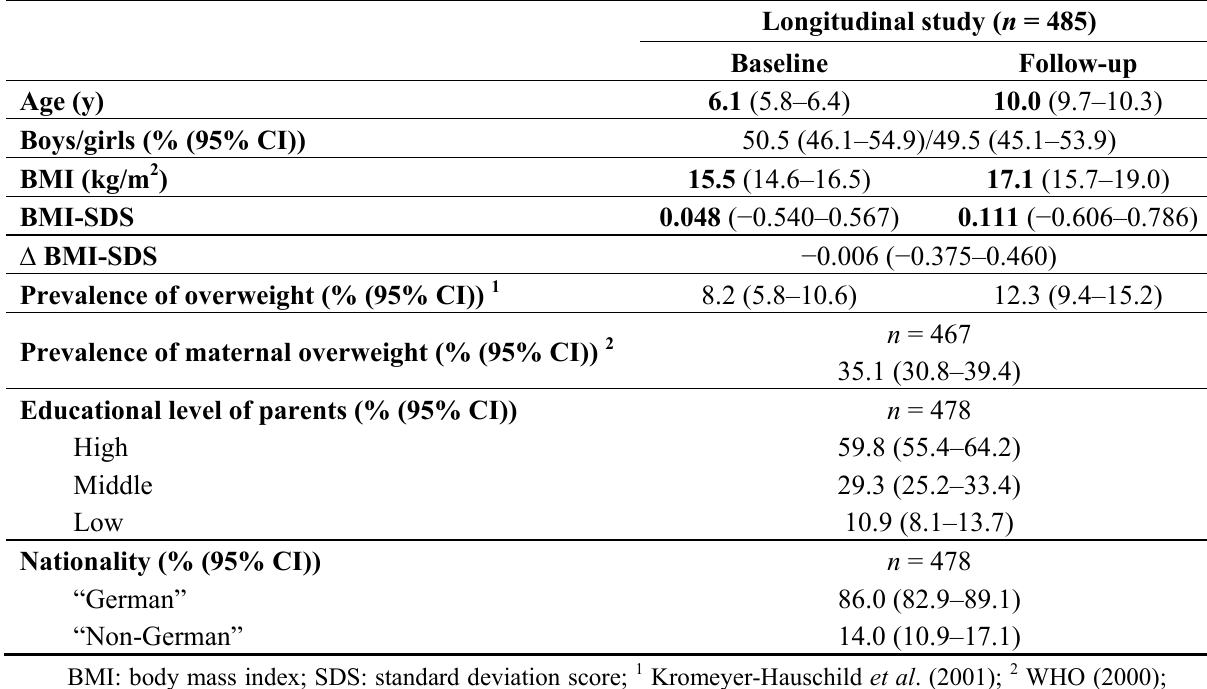
Table 1. Characteristics of the study